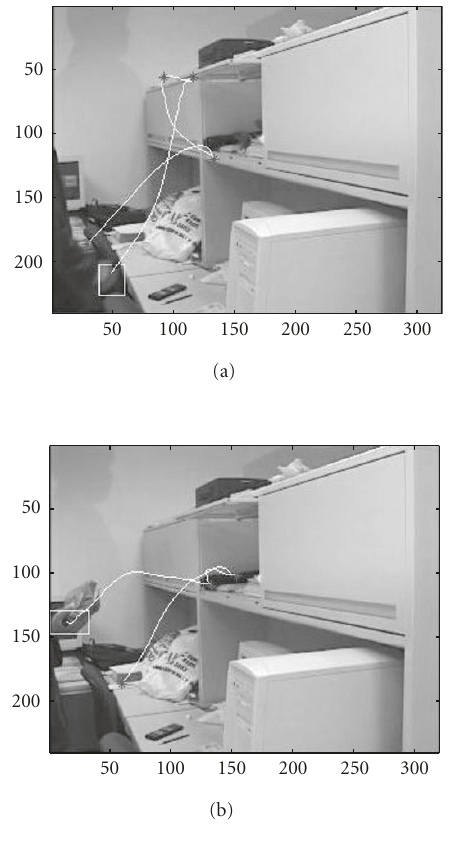
Figure 5: Sample images from UCF